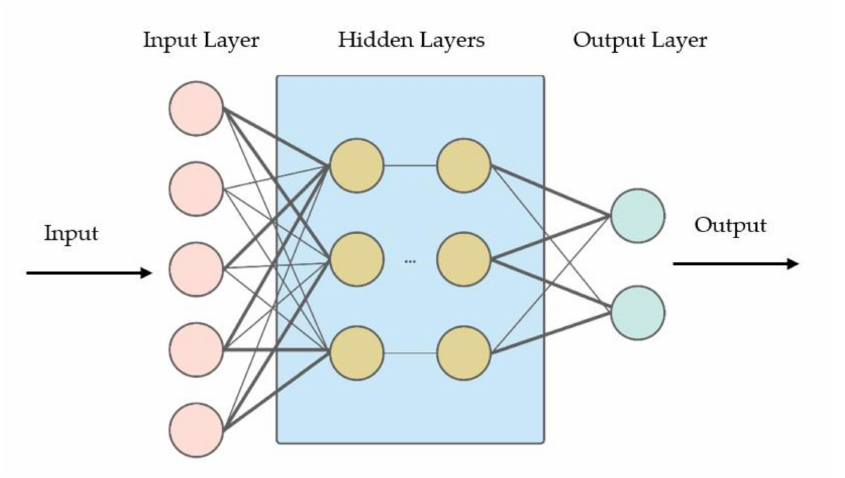
Figure 4. Typical neural network structure.